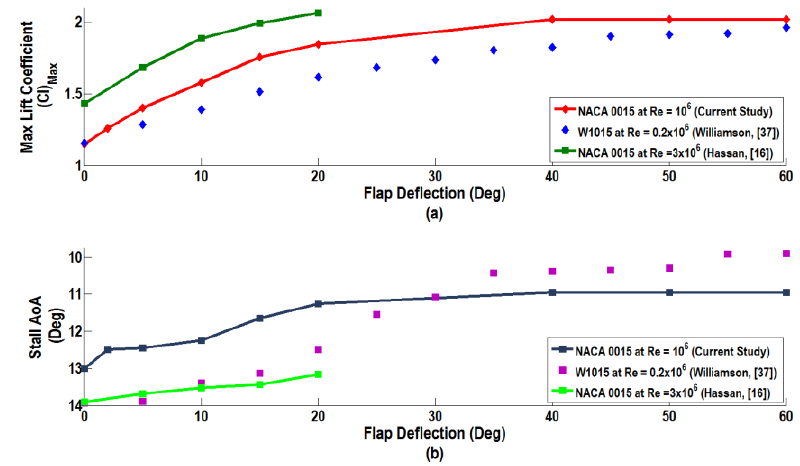
Figure 20. Comparison of effect of flap deflection on ( a ) the maximum lift coefficient and ( b ) the stall angle of attack with the experimental data of Williamson [37] and Hassan [16].